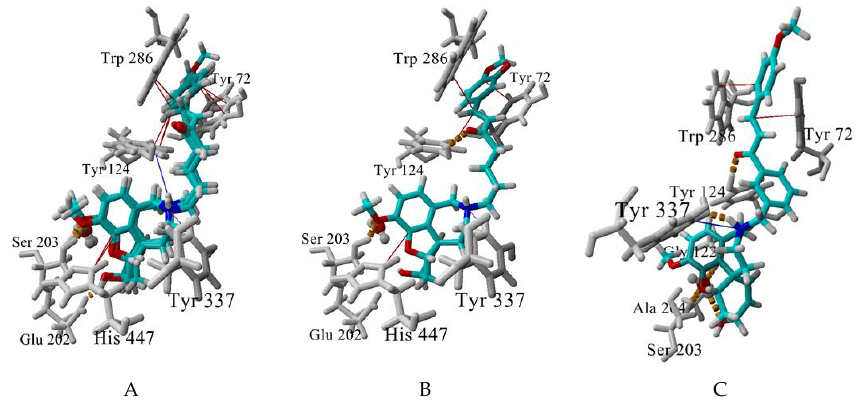
Figure 8. Best-scored docking poses between the compounds 4a , b , f ( A ), 4e ( B ), and 8f ( C ) and AChE. Hydrogen bonds are shown in yellow dashes, cation-π interactions are shown in blue lines and π-π (including p-π) interactions, are given in red lines. The structural water molecule within the binding site is presented in ball-and-stick. Interactions are visualized by YASARA (http://www.yasara.org). The linker also takes part in the interaction with the enzyme. The sp 2 C atoms make p-π contacts with Tyr72 and/or Trp286. Additionally, the oxygen atom of the carbonyl group forms a hydrogen bond with Tyr124 ( 4e and 8b , Figure 8B and C). Surprisingly, no π-π stacking was observed between the linker’s benzene and any of the aromatic residues in the binding site. The terminal aromatic moieties fit well into the PAS. There are two different orientations, but all of them make π-π stacking with Trp286 and/or Tyr72.